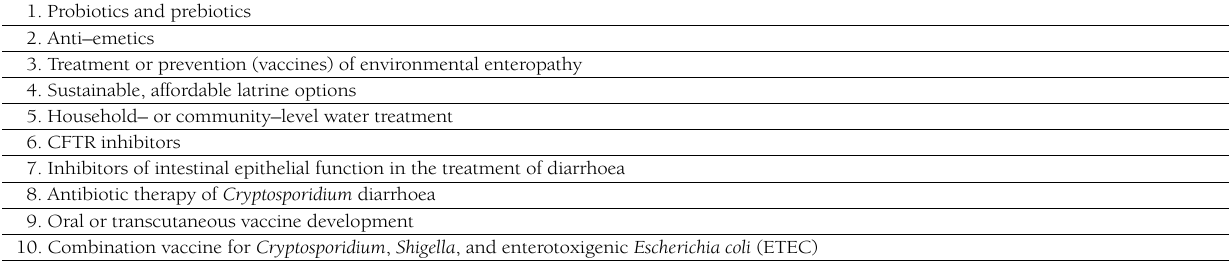
Table 1. The consolidated list of 10 emerging interventions against childhood